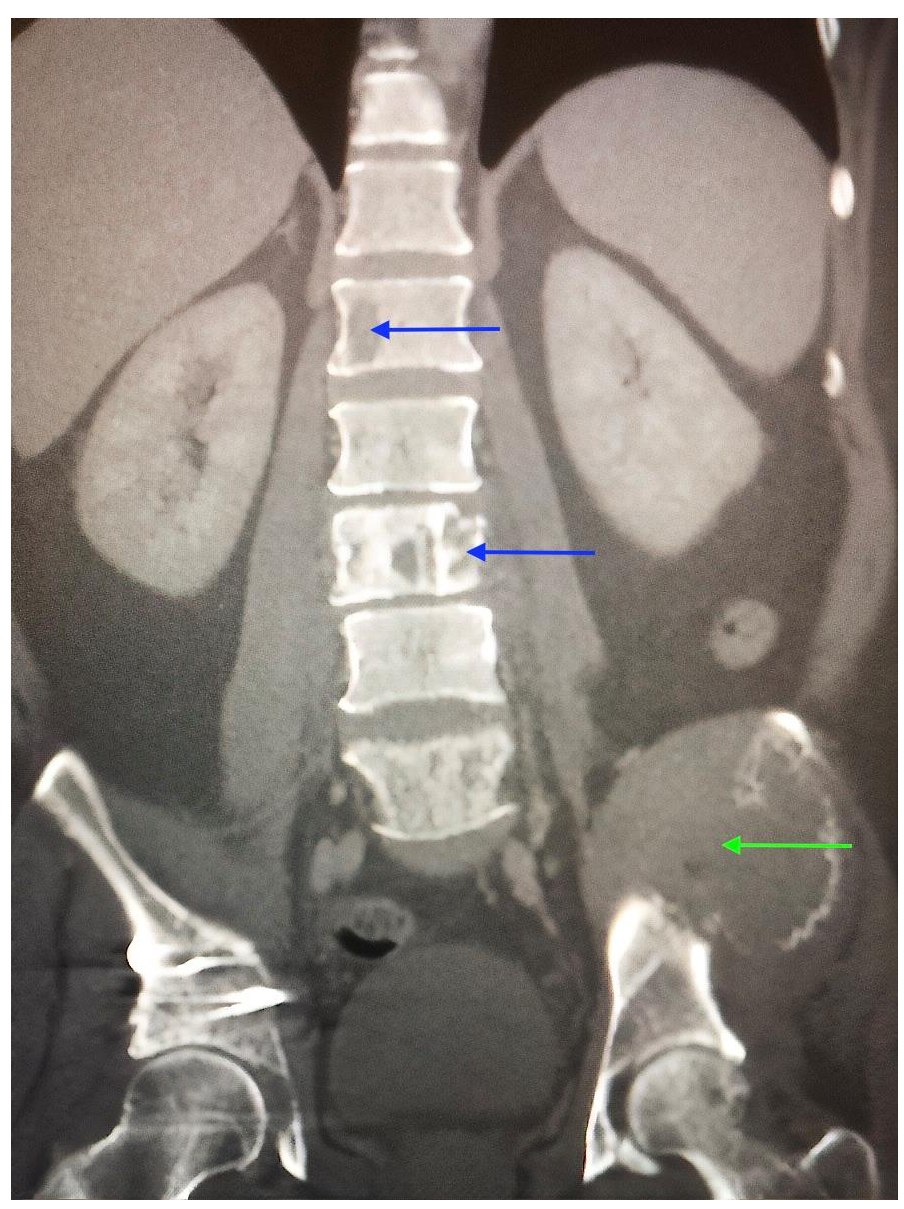
Figure 1. CT scan of the spine and pelvis highlighting multiple areas of bony destruction in the thoracic and lumbar vertebrae. (blue arrows) There is a large mass in the left iliac bone. (green arrow).